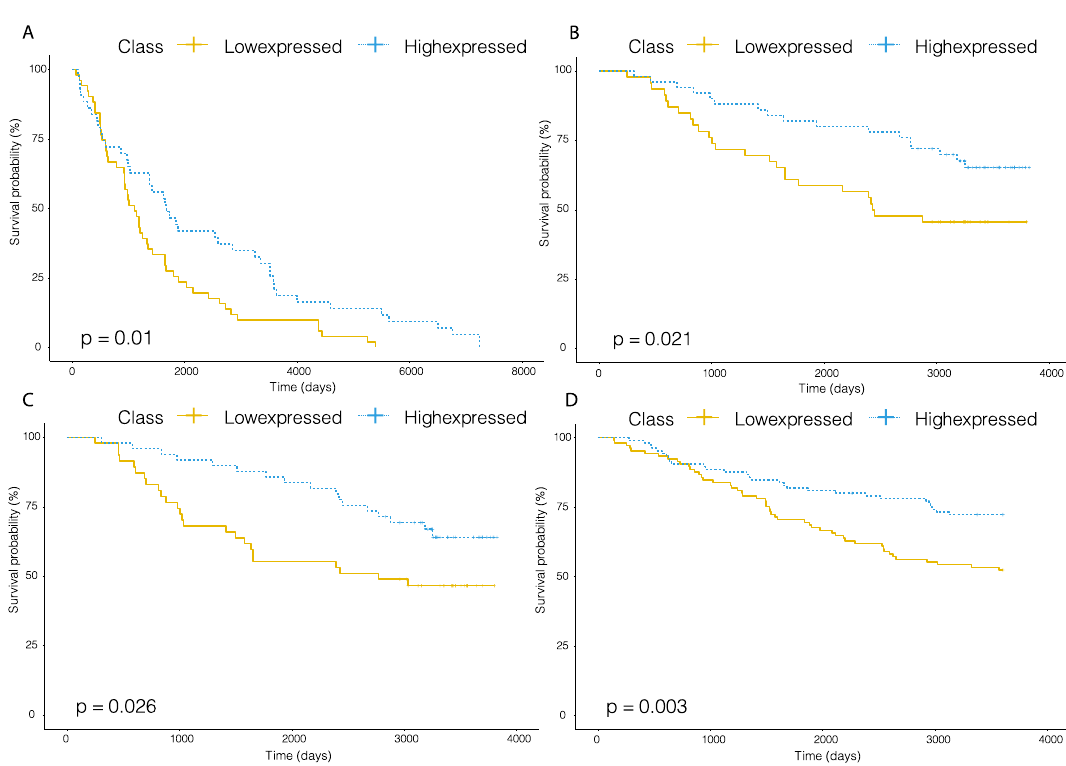
Figure 5. Kaplan–Meyer survival curves of BRCA patients in additional GEO datasets, stratified by drug- specific miRNA marker identified from TCGA data. ( A ) BRCA patients in GSE40267 stratified by miR-363. ( B ) BRCA patients in GSE19783 stratified by miR-20b. ( C ) BRCA patients in GSE19783 stratified by miR-628. ( D ) BRCA patients in GSE22220 stratified by